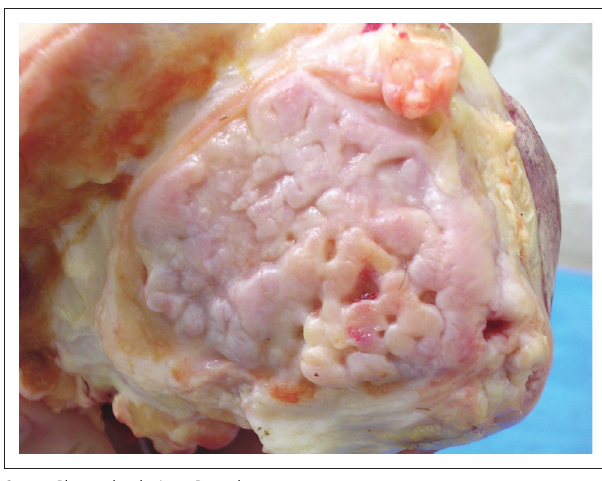
Source : Photo taken by Leon Prozesky FIGURE 8: Note irregular fibrous articular cartilage covering the femur